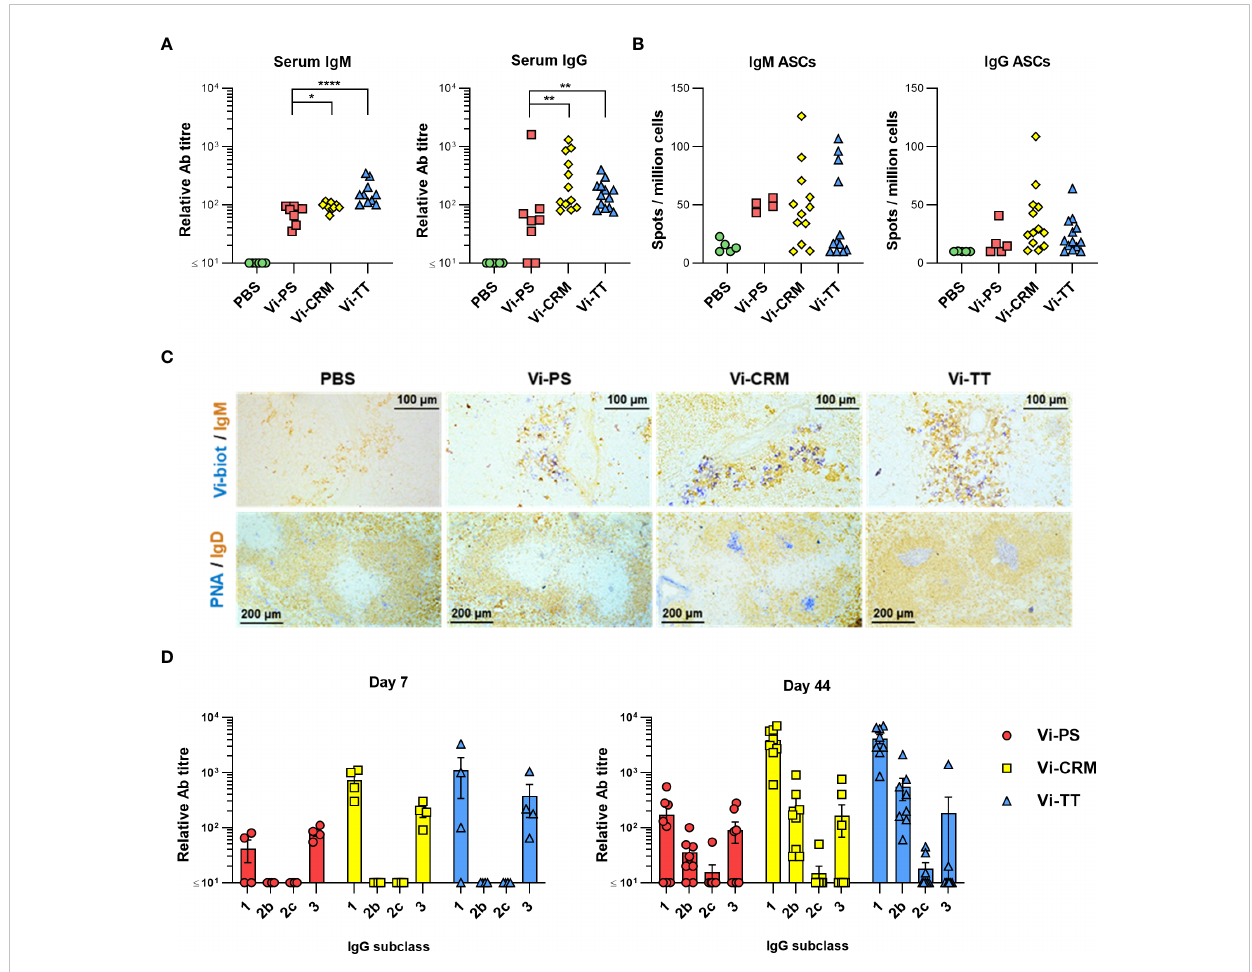
FIGURE 1 TCV induce rapid IgM and IgG responses and GC. (A) Sera from C57Bl/6 mice 7 days after i.p injection of 2 µg Vi-PS, Vi-CRM 197 , Vi-TT or PBS were assessed by ELISA for anti-Vi IgM and IgG. Data pooled from 3 experiments with n = 2 or 4 mice/group. (B) Splenic antibody secreting cells (ASCs)